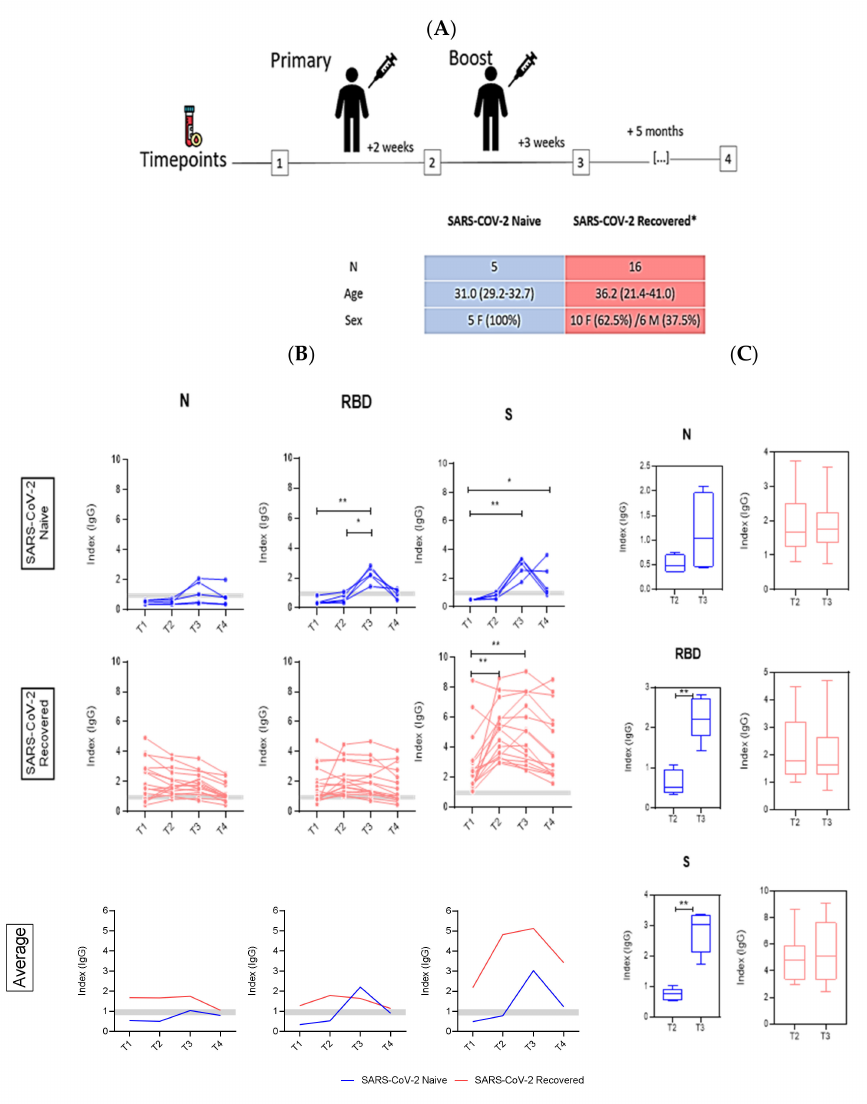
Figure 1. Antibody responses following CoronaVac vaccination in SARS-CoV-2-naïve (blue) and -recovered (red) individuals. ( A ) Study design showing the blood collection timepoints. ( B ) Kinetics of anti-nucleocapsid (N), anti-spike (S), and anti-RBD IgG antibodies in vaccinated (naïve, recovered, and average) individuals. The cut-off for samples to be considered positive was ≥ 1.1 and the borderline zone ranges from 0.8–1.1 (horizontal gray bars). Statistics were calculated using Kruskal– Wallis test. ( C ) Comparison between timepoints after first (T2) and second dose (T3) in naïve and recovered individuals using the unpaired Mann–Whitney test. * p < 0.05, ** p <